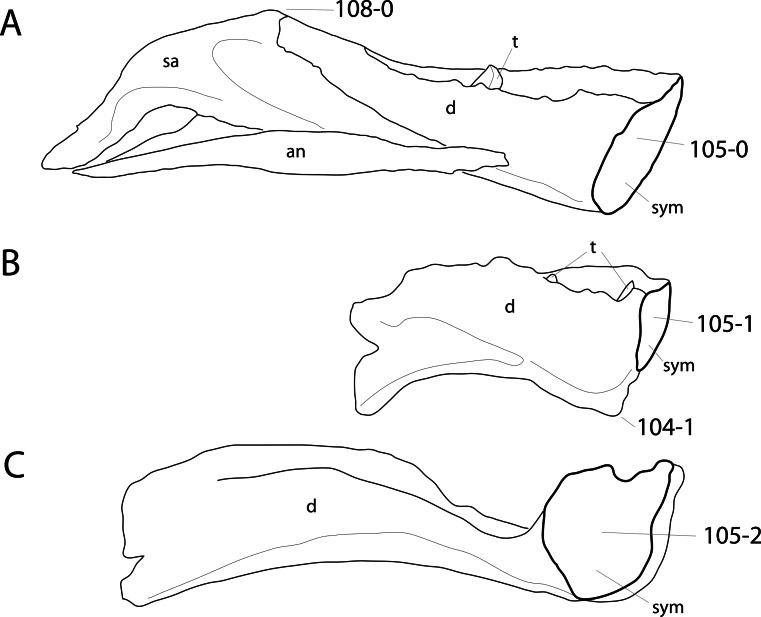
Neosauropod dentaries.Left dentary of Camarasaurus lentus DNM 28 (A; traced from Madsen, McIntosh & Berman, 1995), Dicraeosaurus hansemanni MB.R.2372 (B; traced from Janensch, 1935), and Nigersaurus taqueti MNN GAD512-10 (C; traced from Sereno et al., 2007) in lingual view. Note the chin-like ventral process in Dicraeosaurus (B; C104-1), the different shapes of the symphysis (C105-1 to 3), and the high elevation of the coronoid eminence in Camarasaurus (A; C108-0). Abb.: an, angular; d, dentary; sa, surangular; sym, symphysis; t, tooth. Scaled to the same anteromedial height of the dentary.